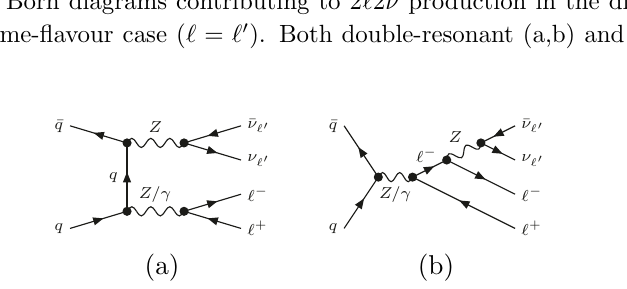
= ‘ ). Both double-resonant (a) and single-resonant 6